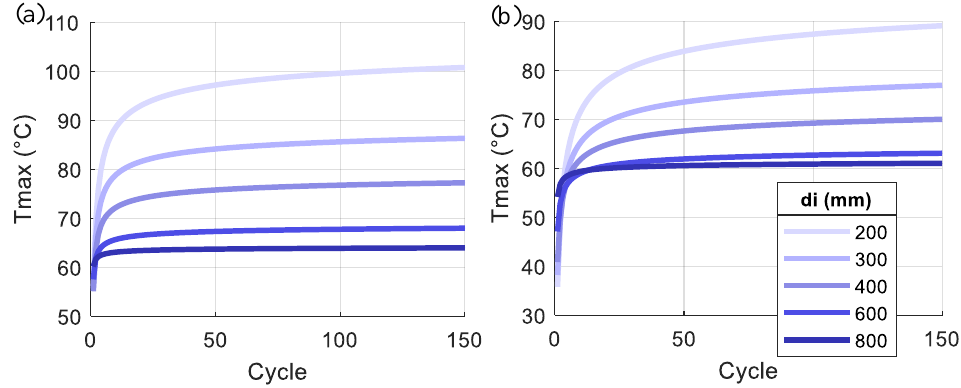
Figure 15. Maximum temperature in each loading cycle for different d i at: ( a ) the midpoint of the pile section; ( b ) the outer surface of the pile section.